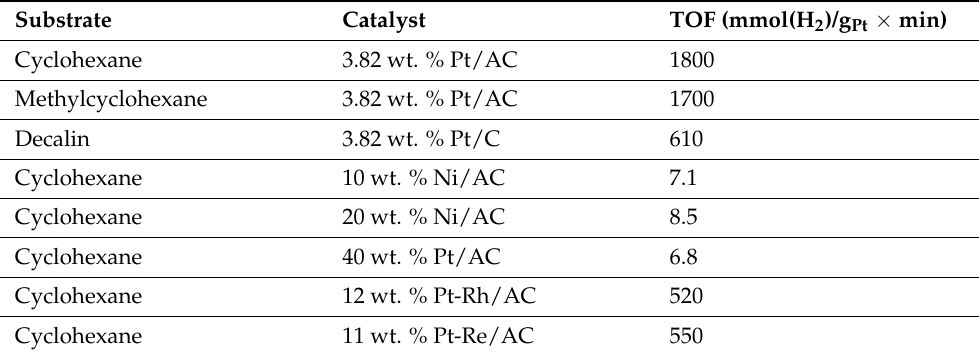
Table 2. Hydrogen release rates during dehydrogenation of some cycloalkanes.